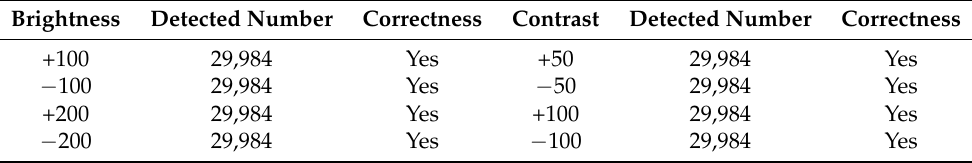
Table 6. Quality of decoded bar-codes affected by changes in brightness and contrast.